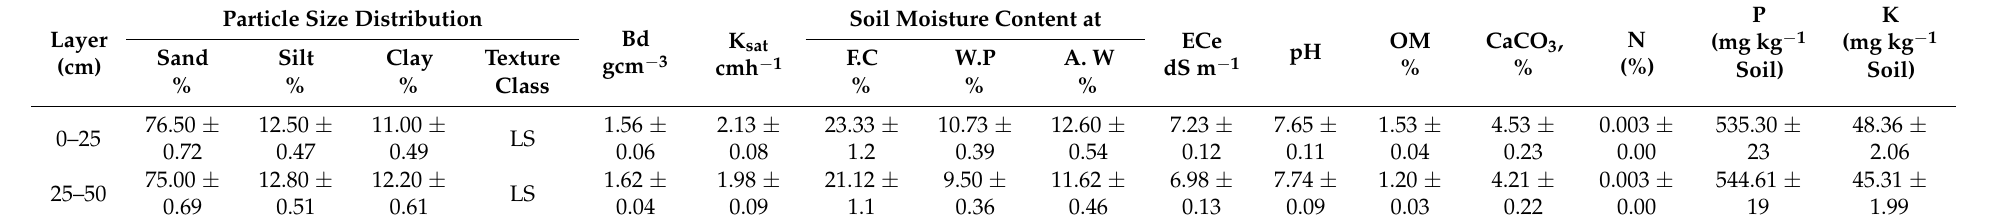
Table 1. Some initial physical properties of the studied